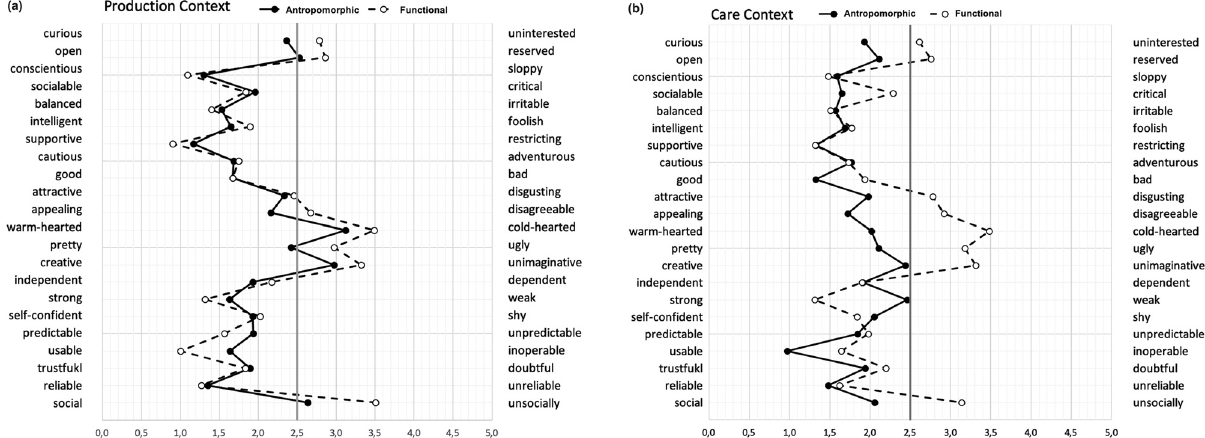
Figure 7: Perception of anthropomorphic and functional designs ( within - subject factor ) in care and production usage scenarios ( between - subject factor ) measured on a semantic di ff erential. ( a ) production scenario, ( b )